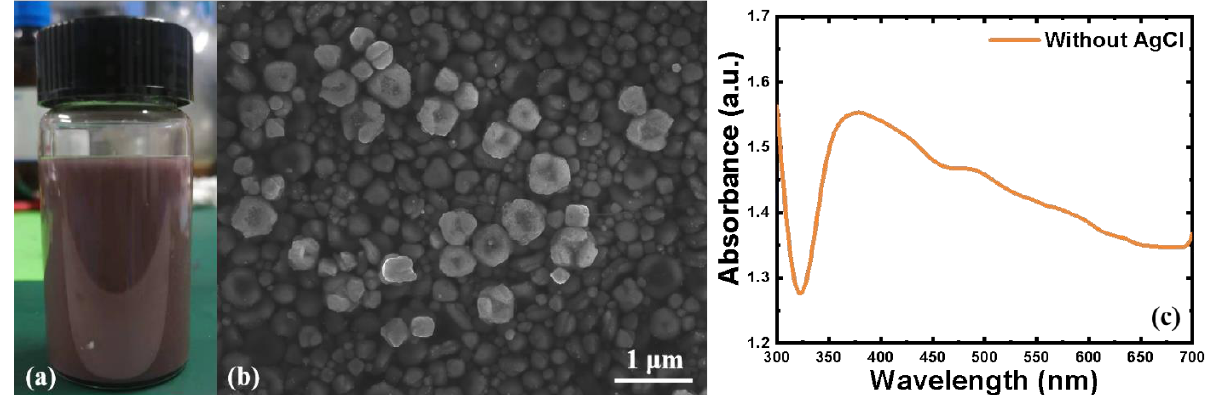
Figure 4. ( a ) Picture of product solution without adding AgCl; ( b ) Scanning electron microscopy (SEM) image of the product without adding AgCl; ( c ) UV – vis absorption spectra of product solution without adding AgCl.